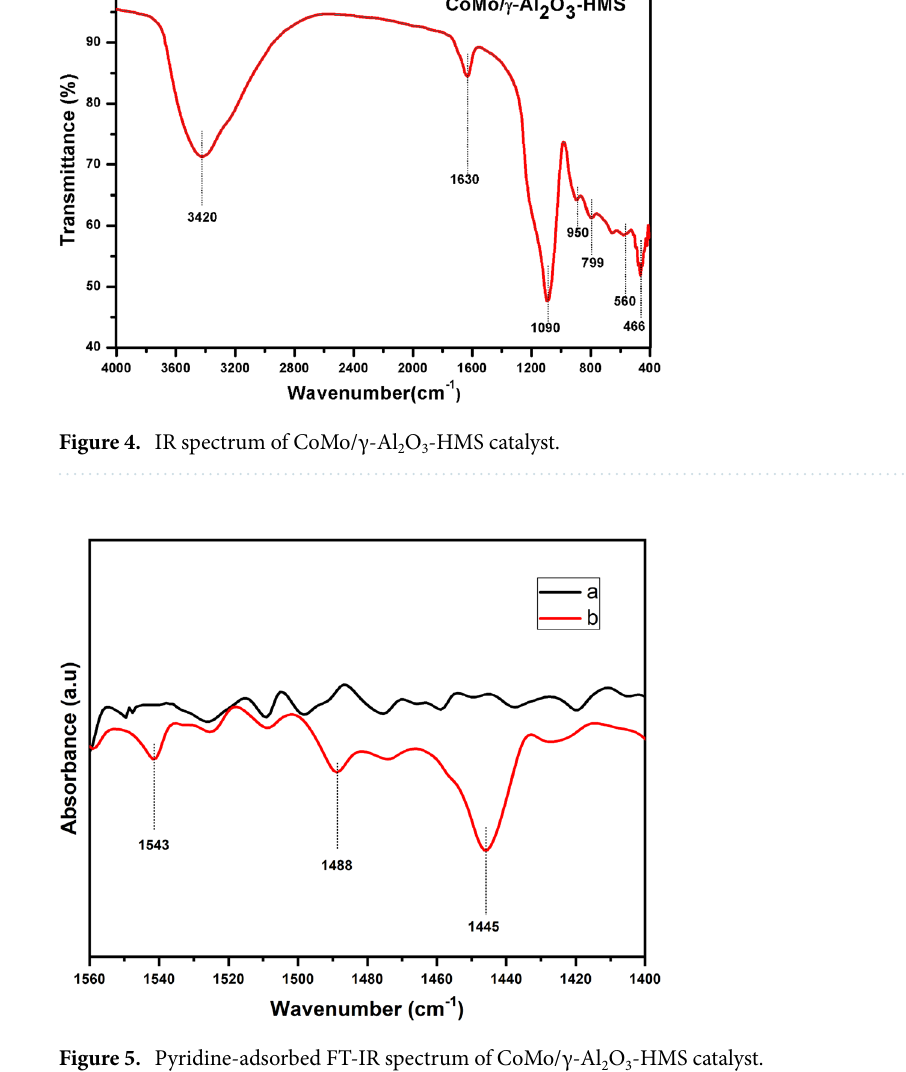
Element Spectral line Energy (eV) Assigned